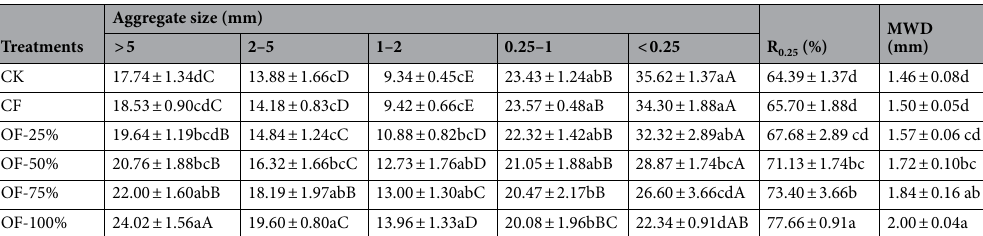
Table 3. Size distribution (%) of water-stable aggregates in different fertilization treatments in a gravel- mulched field. Lower-case letters in the same column indicate significant differences in fertilization. Upper- case letters in the same row indicate significant differences in aggregate size ( p < 0.05). CK, no N fertilizer; CF, N fertilizer without organic fertilizer; OF-25%, OF-50%, OF-75%, and OF-100%, 25%, 50%, 75%, and 100% organic fertilizer. R 0.25 , the percentage of macroaggregates (> 0.25